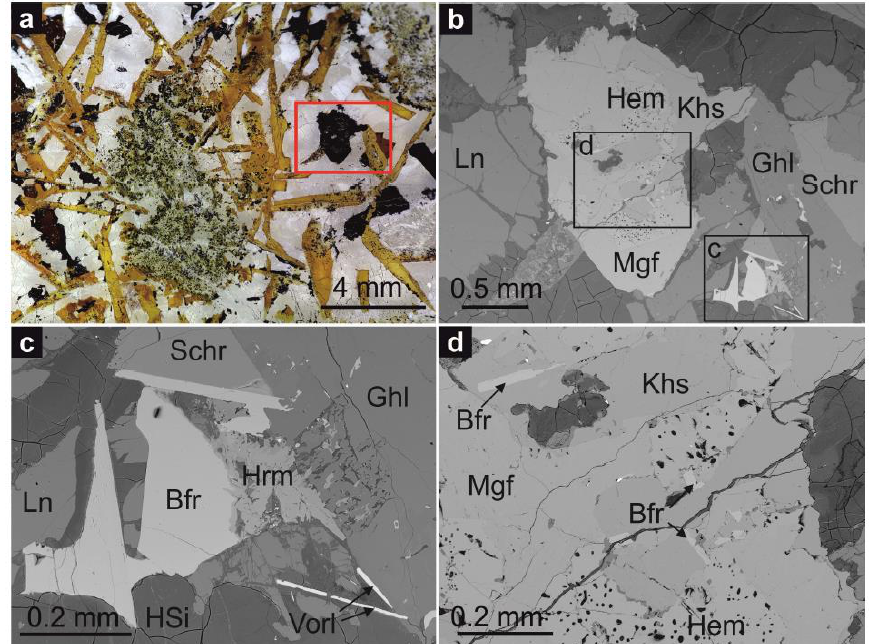
Figure 1. ( a ) Fragments of larnite-gehlenite paralava from Har Parsa with barioferrite aggregates and gehlenite porphyroblasts (megacrysts); fine-grained greenish gehlenite rock occurs in the center. The minerals can be distinguished by color: garnet—dark-brown; gehlenite—orange to yellow-brown; larnite—light-grey to colorless; barioferrite—black; secondary hydrous Ca-silicates—chalk white to light-grey. The area shown in the red frame is magnified in Figure 1b; ( b ) backscattered-electron (BSE) image of larnite-gehlenite paralava with barioferrite crystals. The framed areas are magnified in Figure 1c,d; ( c ) subhedral barioferrite crystals with harmunite; ( d ) aggregate composed of magnesioferrite, hematite, and khesinite with lamellar barioferrite crystals. Labels: Bfr—barioferrite,